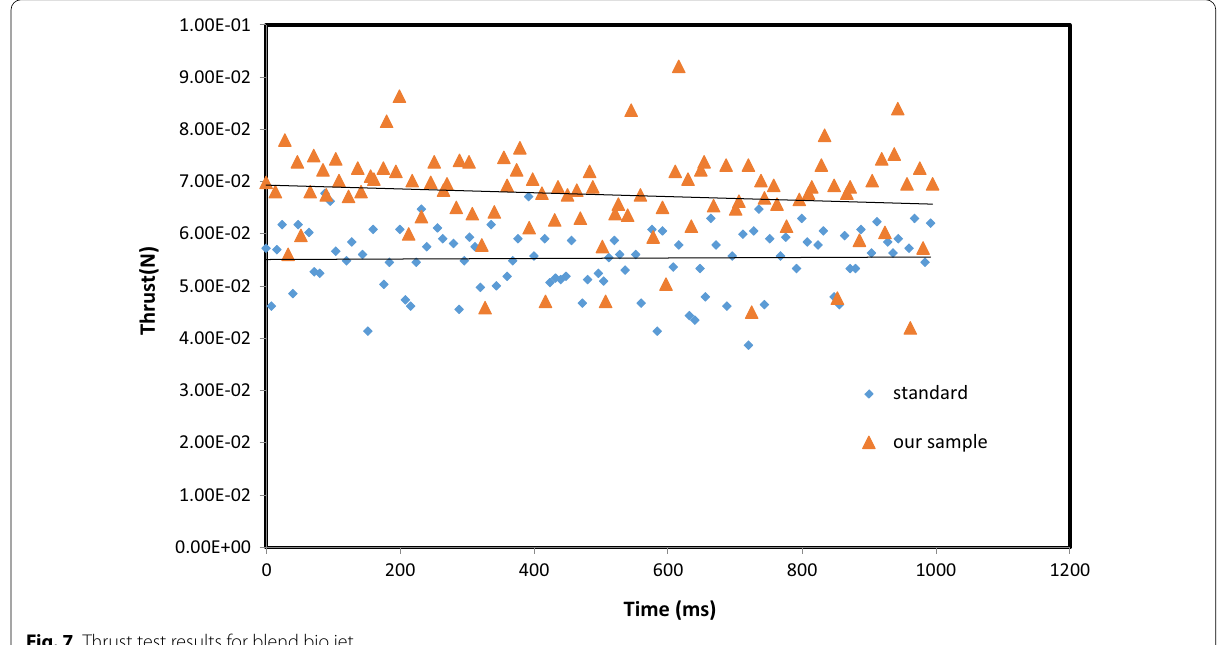
Fig. 7 Thrust test results for blend bio